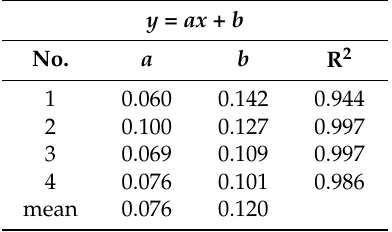
Table 11. Properties of the anodizing regression lines from Figure 12.